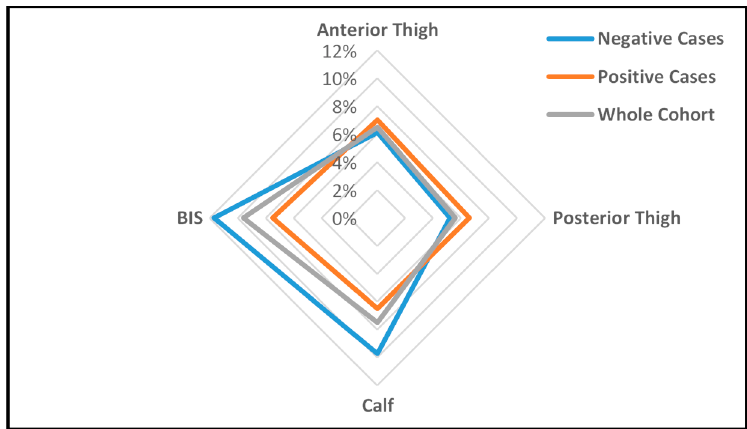
Figure 3. Percentage between-leg differences using the Indurometer and BIS in the LF antigen-negative cases, LF antigen-positive cases, and whole cohort. Data points which are closer to the outer ring indicate greater between-leg differences.